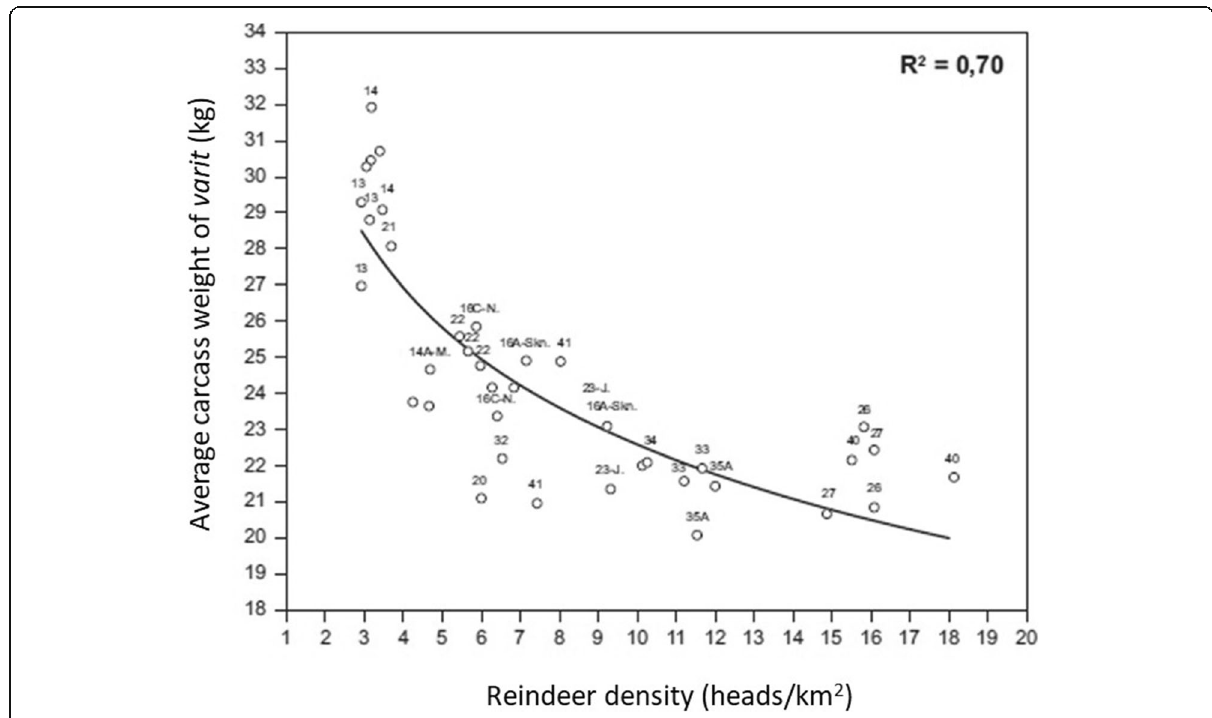
Fig. 4 Relationship between carcass weights of varit and herd density in mainland districts according to Ims and Kosmo